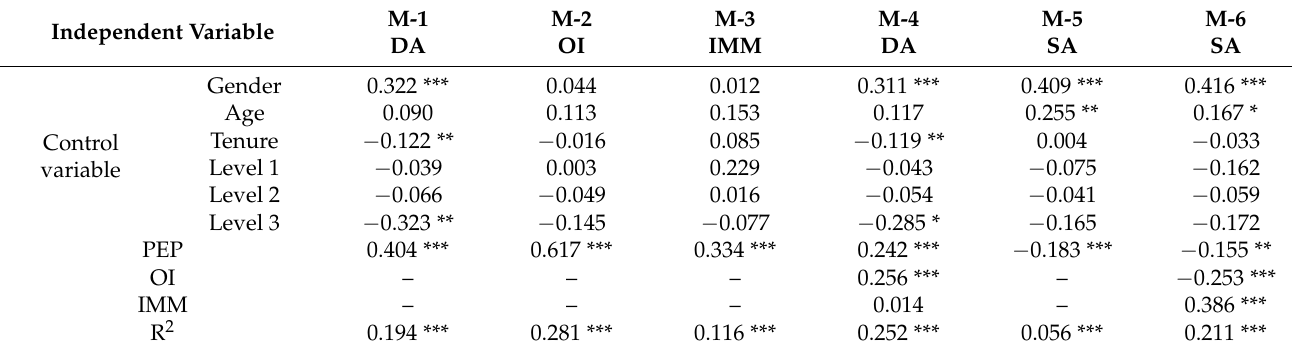
Table 3. Test of mediating effects.